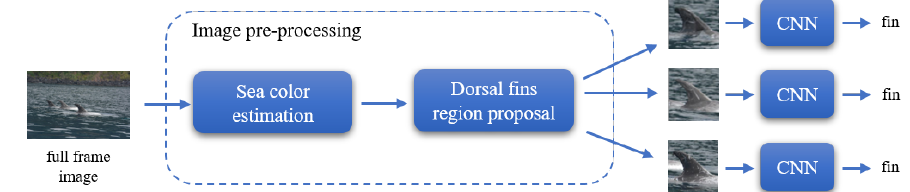
Figure 4. High level block diagram of the proposed approach. A full frame input image is first pre-processed in order to extract regions of interest that may contain a dorsal fin. Then, the classification of fin vs. no-fin is performed using a Convolutional Neural Network (CNN) specifically designed to this end. The CNN block refers to the same Convolutional Neural Network that is used to classify each cropped